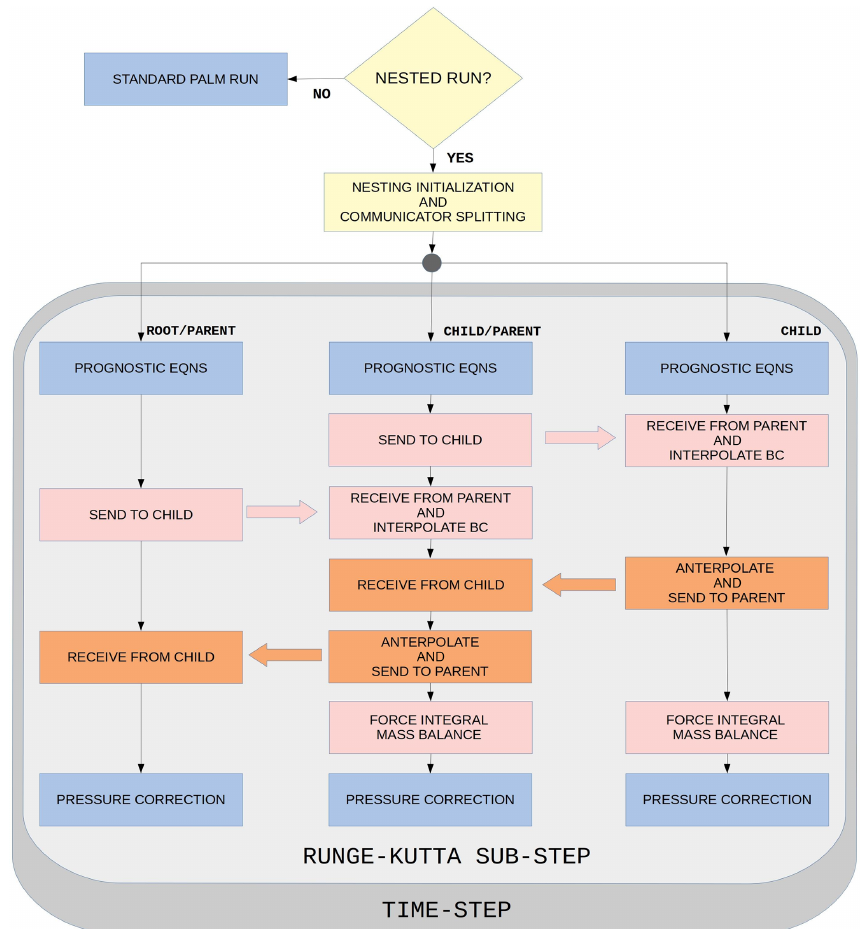
Figure 2. Flow chart illustrating the nesting actions in the case of three domains in cascading order. In the case of more than three domain levels, more branches similar to the current middle branch would be added. Blue boxes represent baseline PALM actions, while the other colors indicate nesting-specific actions. In one-way coupling only the actions indicated by pink color are